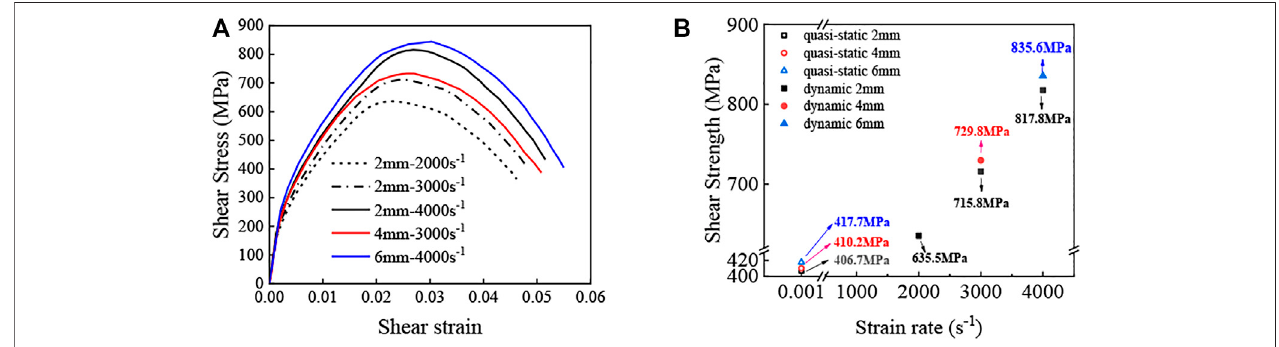
FIGURE 9 | Shear performance comparison with different welding lengths under different strain rates: (A) dynamic shear stress – strain curves and (B) shear